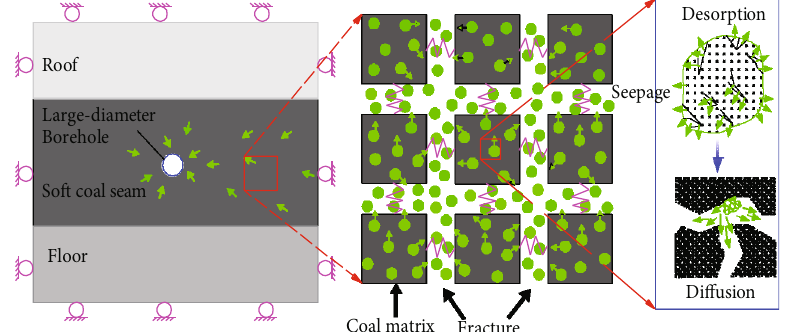
Figure 1: Gas migration process during extraction form soft coal seam, modi fi ed from literature